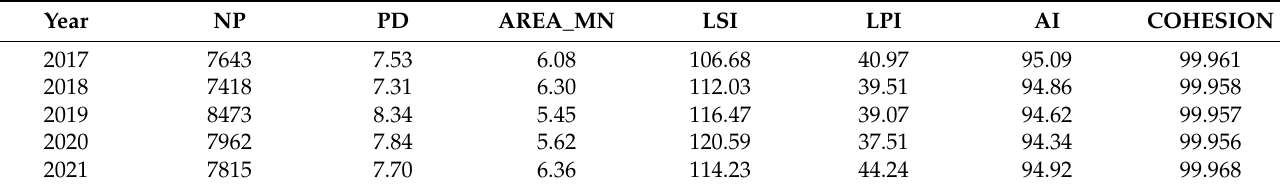
Table 6. Impervious Surface Landscape Pattern Index,